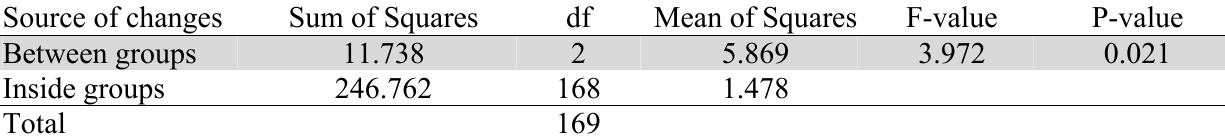
The results of ANOVA test Source of changes Sum of